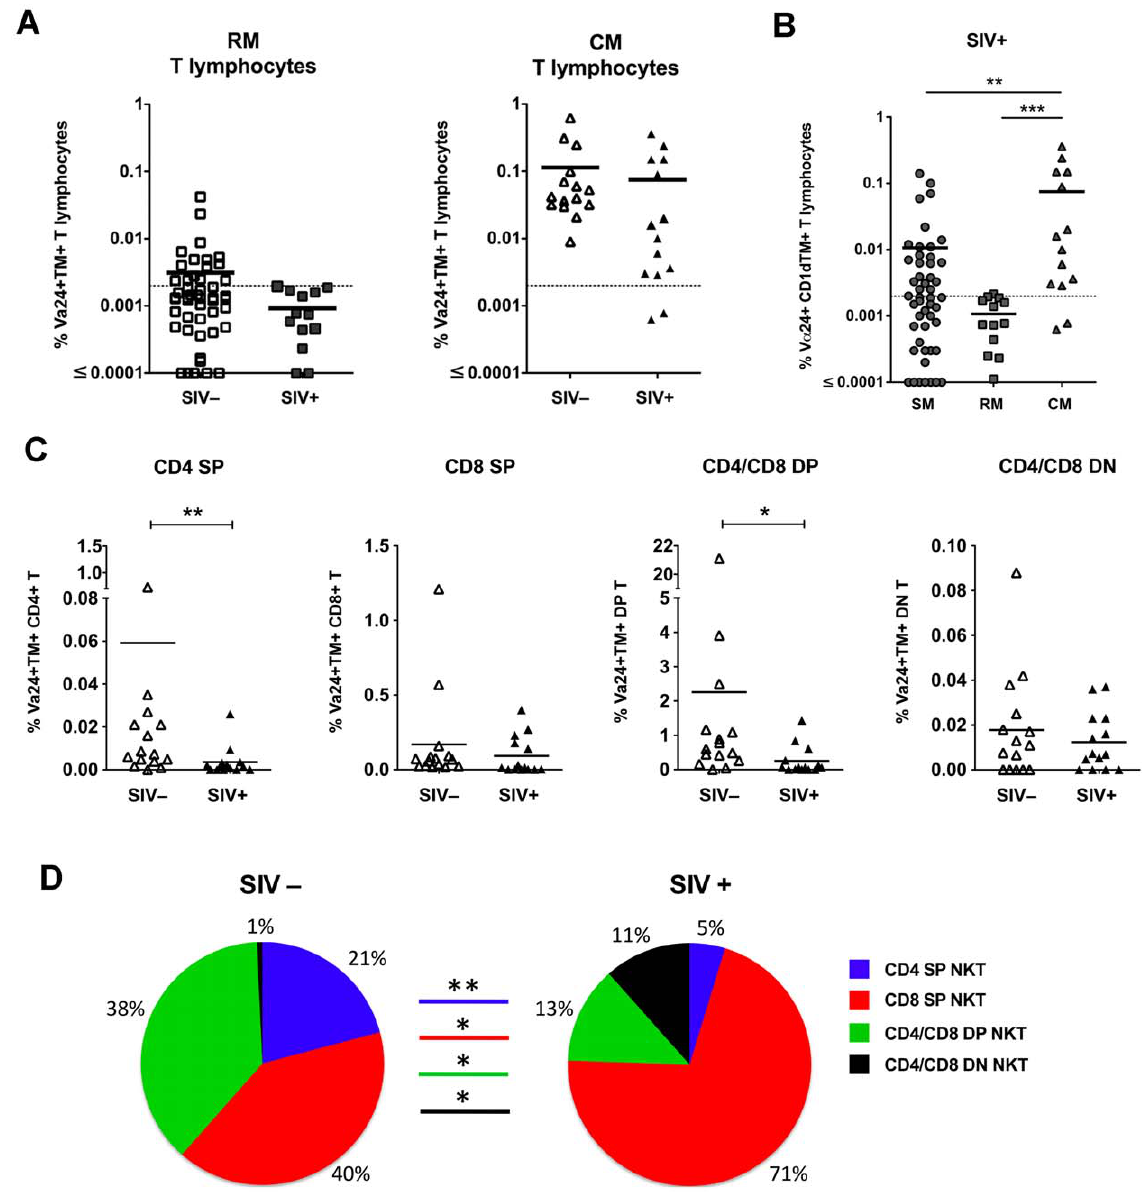
Figure 4. Frequency and subset distribution of NKT lymphocytes in SIV-infected macaques. A) Percentage of total NKT lymphocytes in peripheral blood T lymphocytes of SIV-negative and SIV-infected RM and CM. Dotted line at 0.002% denotes the limit of detection. B) Percentage of total NKT lymphocytes in peripheral blood of SIV-infected SM, RM, and CM. ** P , 0.01, *** P , 0.001 Mann-Whitney U test. C) Comparison of frequencies of CD4 + SP, CD4/CD8 DP, CD8 + SP and CD4/CD8 DN NKT subsets in peripheral blood of 15 SIV-negative CM and 14 SIV-infected CM. Horizontal bars denote mean values. D) Pie charts showing frequency of CD4 + SP, CD4/CD8 DP, CD8 + SP and CD4/CD8 DN NKT subsets in total NKT lymphocytes of SIV-negative and SIV-infected CM. * P , 0.05 and ** P , 0.01 Mann-Whitney U